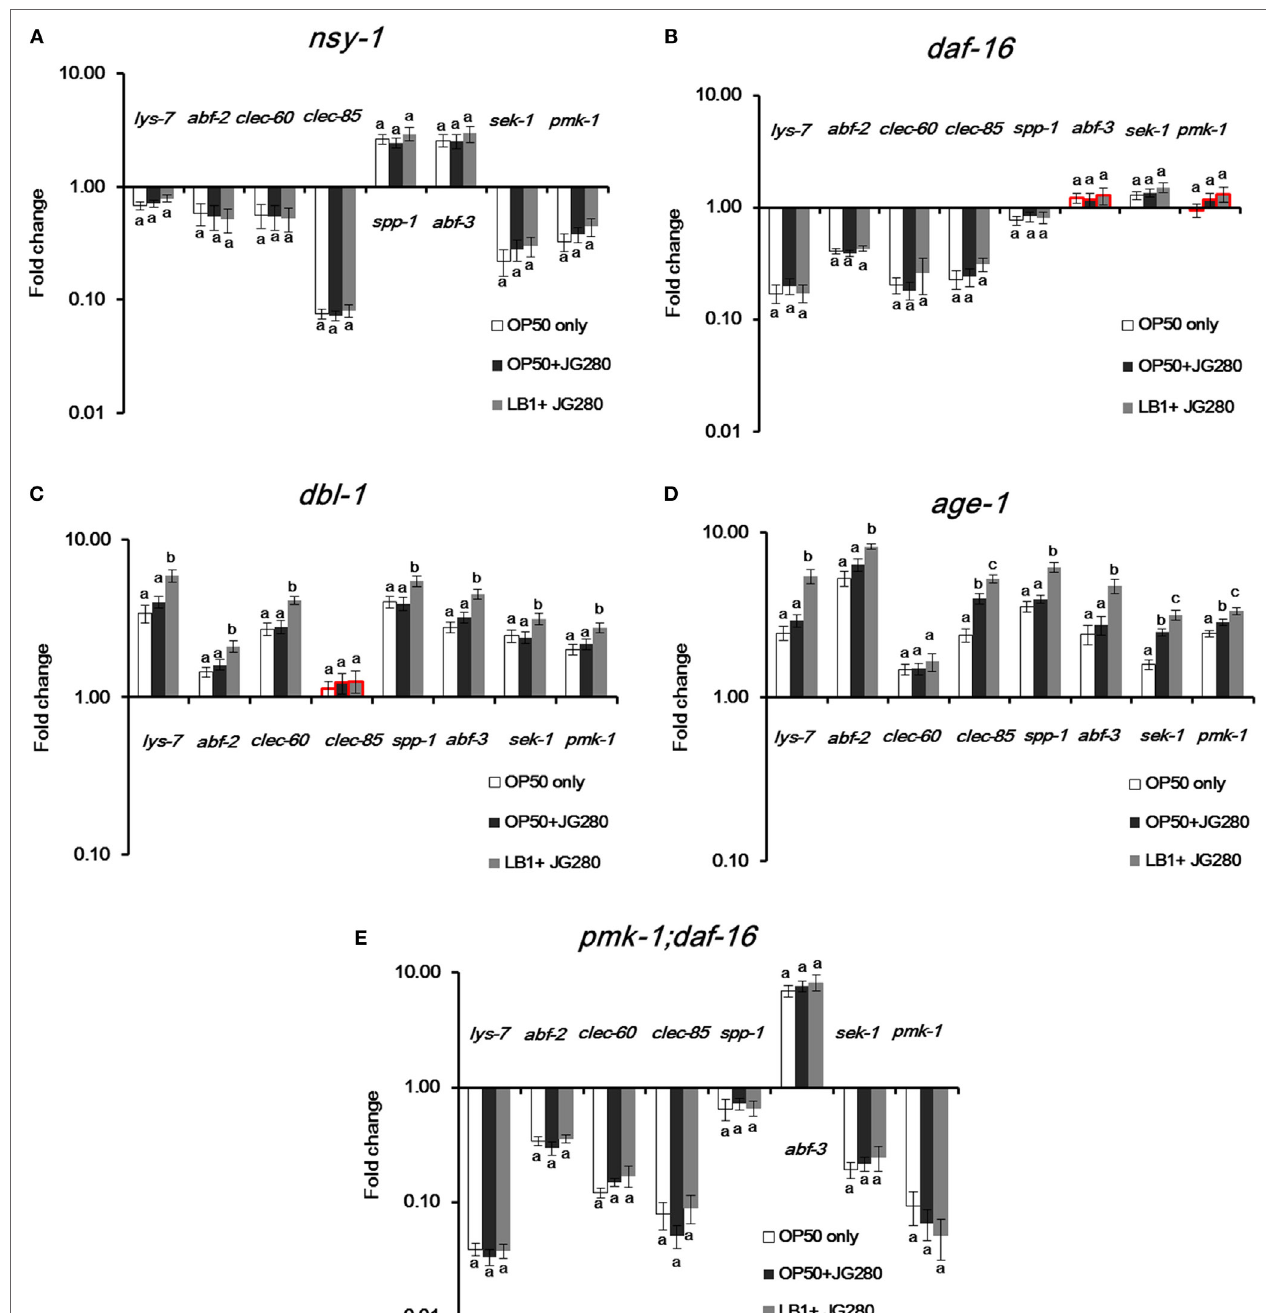
FigUre 5 | Gene expression of selected Caenorhabditis elegans mutants in response to the treatment of E. coli OP50, Enterotoxigenic Escherichia coli (ETEC) JG280 only, or ETEC JG280 after pretreatment with Lactobacillus zeae LB1. The nematode was sampled on day 2 of the life-span assay. The mutants are defective in dbl-1 (a) , age-1 (B) , nsy-1 (c) , daf-16 (D) , or in both d pmk-1 and daf-16 (e) . The control group is the level of gene expression in C. elegans fed OP50 only (open bars). Relative expression was determined using the 2 −ΔΔ Ct method. The first Δ CT is the comparison between target genes and housekeeping genes. The second Δ CT represents the comparison between the mutants and wild-type. The value of each gene in the wild-type is considered to be 1. Means marked with “a,” “b,” and “c” were significantly different ( P ≤ 0.05) for the same gene among different treatments. While the groups represented by the bars with their borders in red had no significant difference ( P > 0.05) in the gene expression level of the same gene between each mutant and the wild-type strain (N2) that had been subjected to the same treatment, the remaining groups represented by the bars with their borders in black differed significantly for the same gene within the same treatment when compared to the wild-type ( P ≤